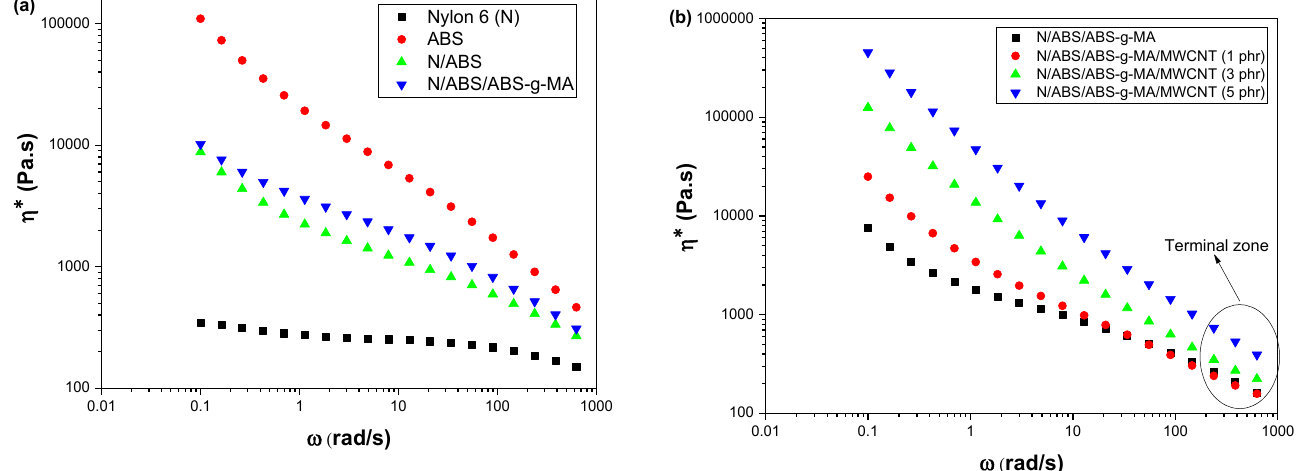
Figure 1. Complex viscosity of Nylon 6, ABS, blends, and nanocomposites as a function of in- creasing MWCNT content. ( a ) Nylon 6, ABS and blends; ( b ) Nylon 6/ABS/ABS-g-MA blend and nanocomposites with different MWCNT contents. N = Nylon 6.